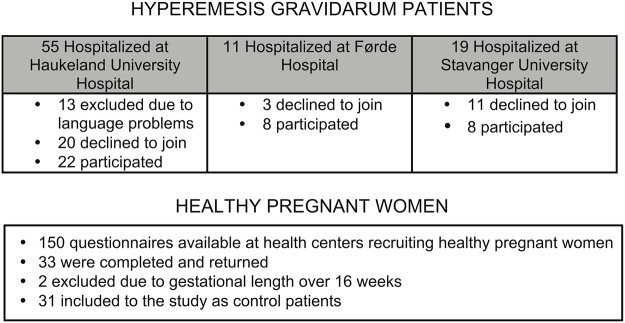
Outline of enrolment in prospective cohort study validating Norwegian PUQE-24* in HG^ patients (n = 38) and healthy pregnant women (n = 31).*Pregnancy-Unique Quantification of Emesis and nausea. ^Hyperemesis Gravidarum.